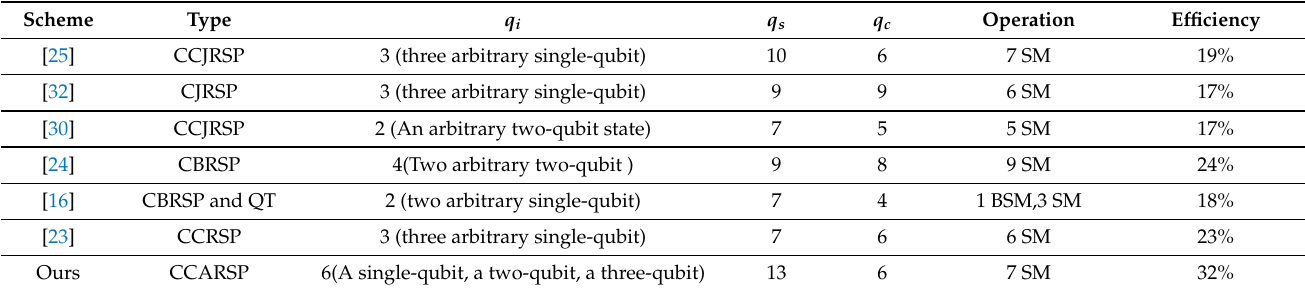
Table 3. Comparison with other RSP schemes, where BSM is short for Bell-state measurement and SM for single-qubit